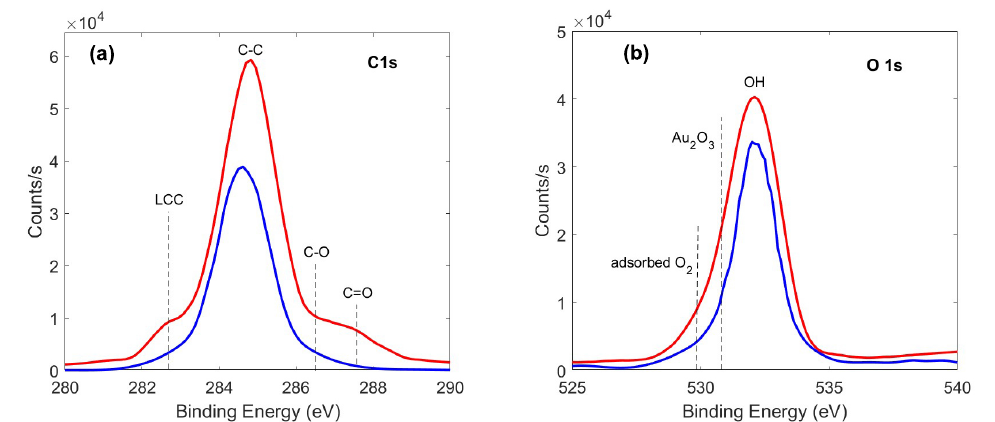
Figure 6. C 1s ( a ) and O 1s ( b ) XPS profiles of Au (blue line) and Au@LCCs (red line)